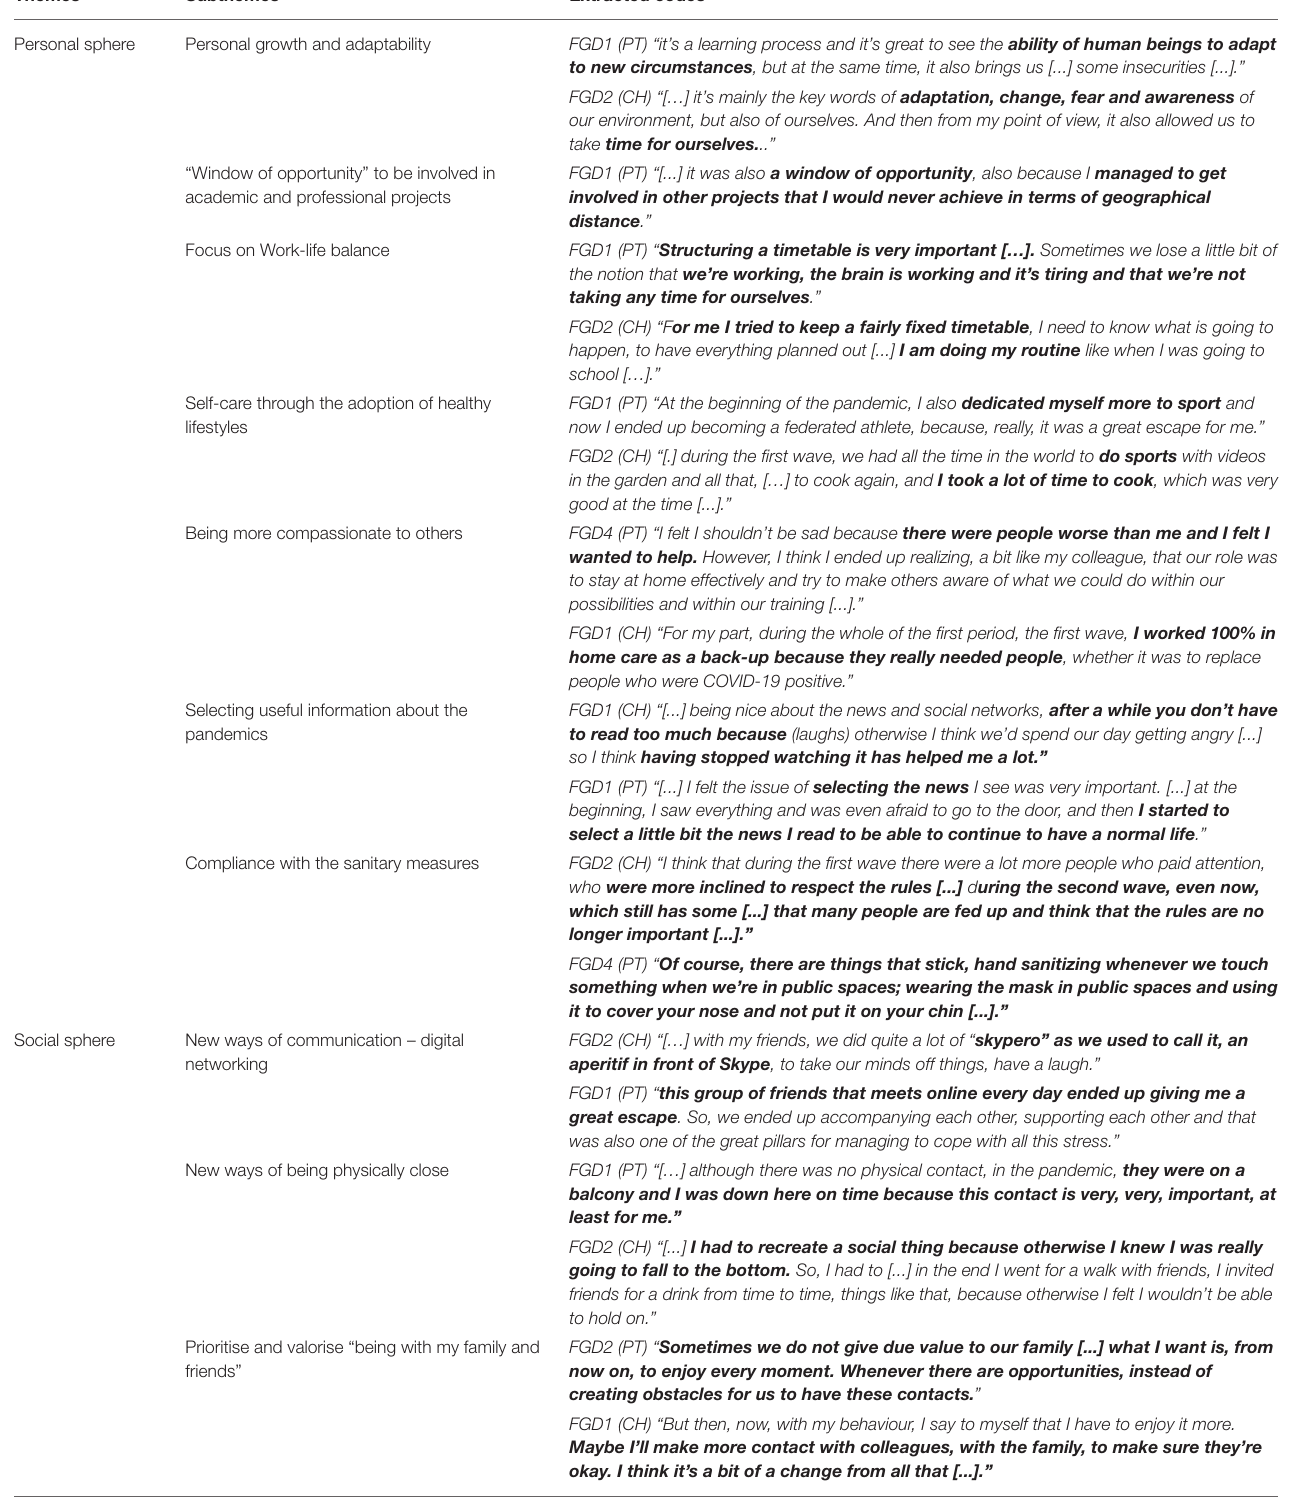
TABLE 5 | The coding structure of main themes, subthemes and quoting